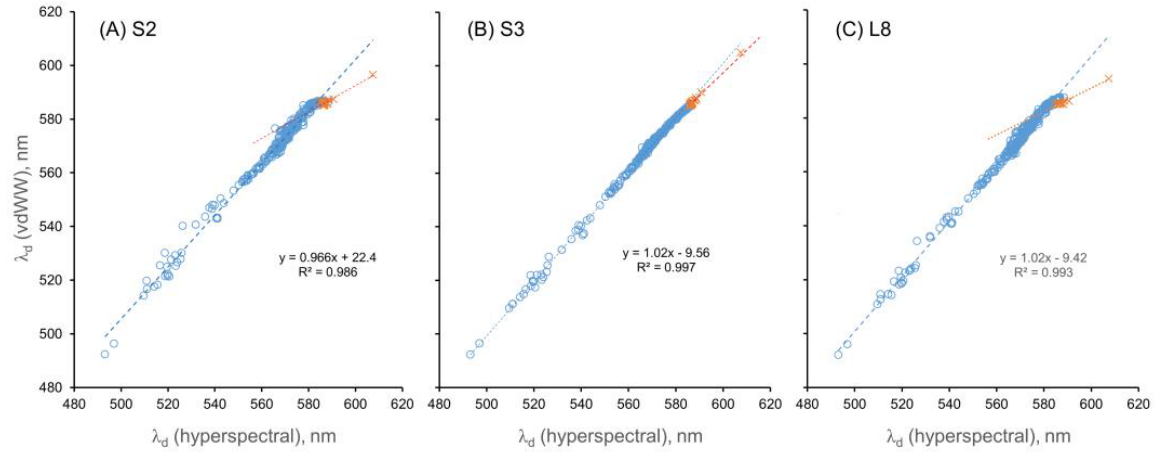
Figure 6. The calculated λ d values using the vdWW method versus λ d,hyp for the three sensors. The blue circles represent data points that were corrected; the orange ( × ) data points represent values where corrections could not be applied. Table 2. Statistical evaluation of λ d values computed using the vdWW and Wang methods compared with λ d,hyp (assumed to be the true values). Statistics were calculated only for the ~180 observations where both methods were